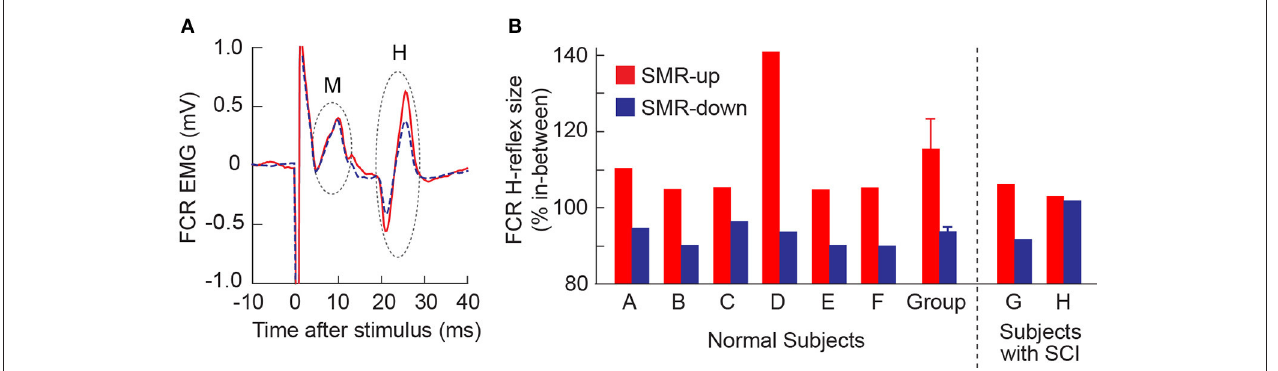
FIGURE 2 | Effects of learned SMR control on the FCR H-reflex. (A) FCR H-reflex during the SMRup (red, solid) and SMRdown (blue, dashed) trials in subject D. About 20 responses were averaged together for each sweep. (B) Average FCR H-reflex sizes during SMRup (red) and SMRdown (blue) trials in normal subjects (A–F) and subjects with SCI (G and H). Group data for normal subjects are also included: H-reflex size averages 116 ± 6 (mean ± SE)% for SMRup trials and 92 ± 1% for SMRdown